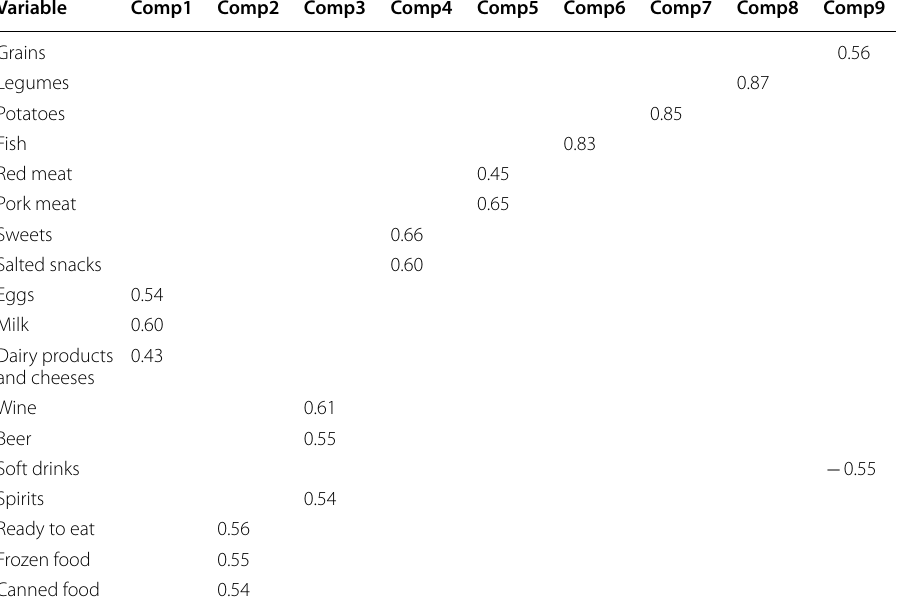
Table shows only factor loadings greater than